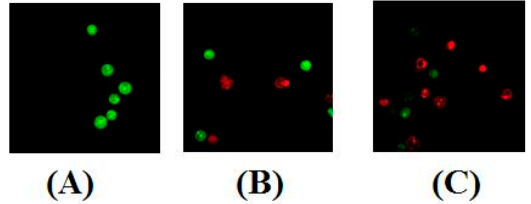
Figure 5. AO / EB staining of Compound 4d in MT-4 cells. ( A ) Cells not treated with 4d (control) and ( B ) cells treated with Compound 4d at 12.50 µ M and, ( C ) cells treated with Compound 4d at 25 µ M concentration.